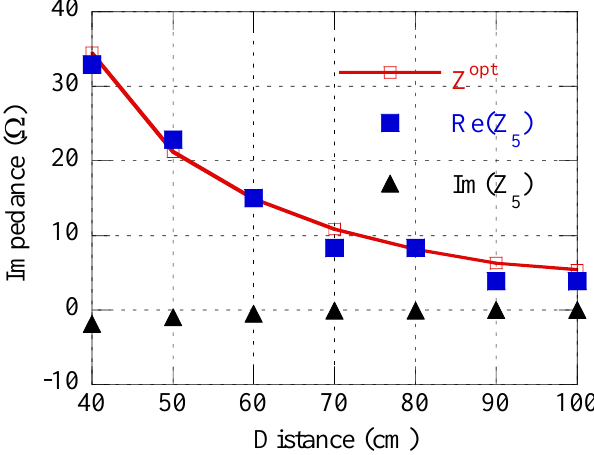
Figure A1. Comparison of Z 2 opt and Z 5 according to the distance.